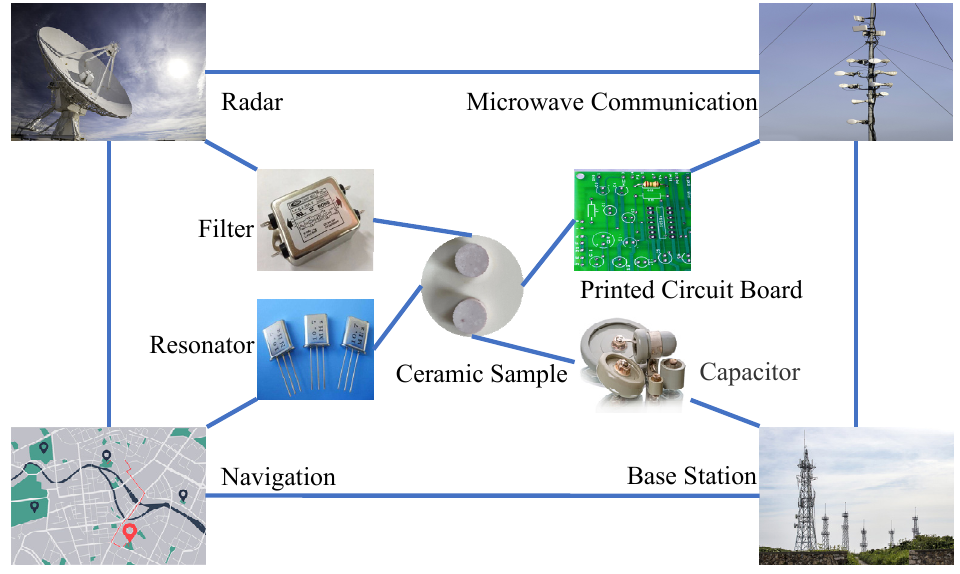
Figure 3. Main applications of microwave dielectric ceramics.